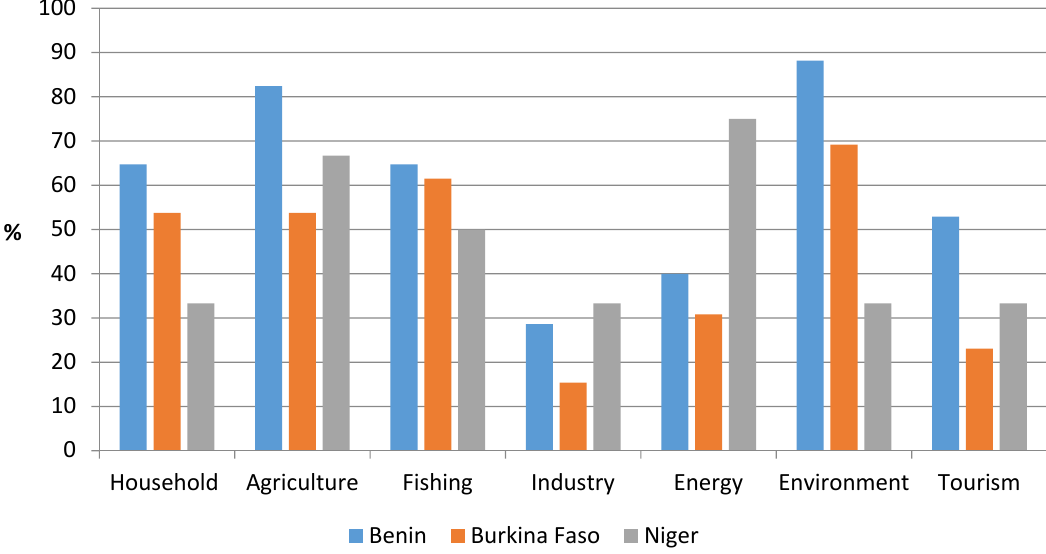
Figure 4. Percentage of experts that consider the seven proposed sectors to be strongly relevant for the Mékrou River Basin, according to the country to which the experts belong.